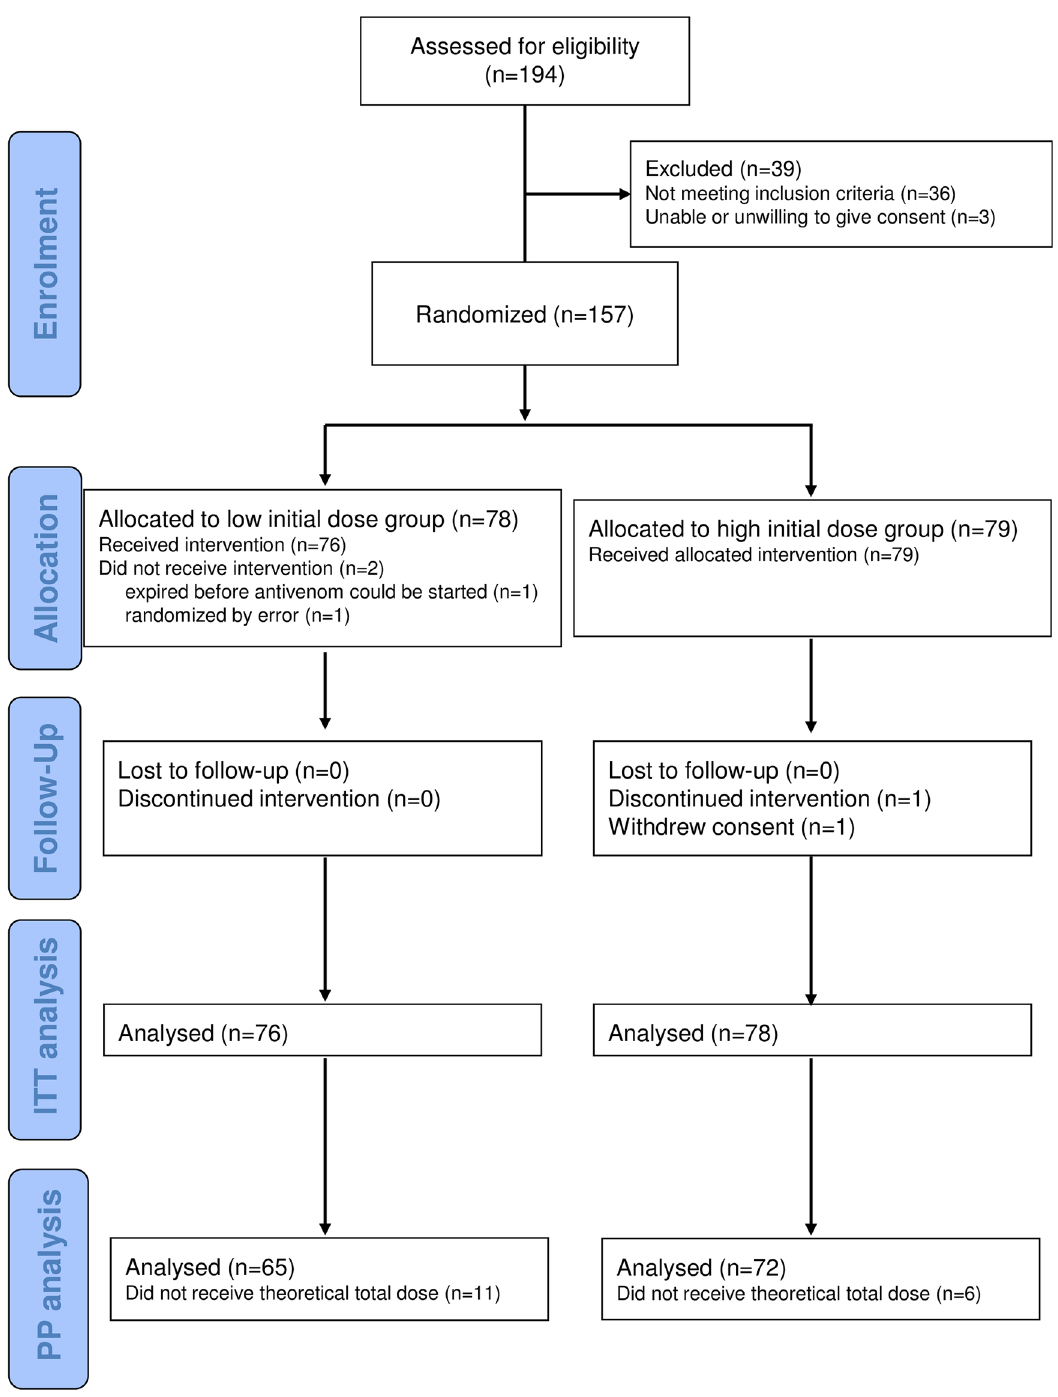
Fig 1. Flow diagram of the progress of participants through the parallel, randomized trial of high initial dose versus low initial dose of snake antivenom for the treatment of neurotoxic envenoming.